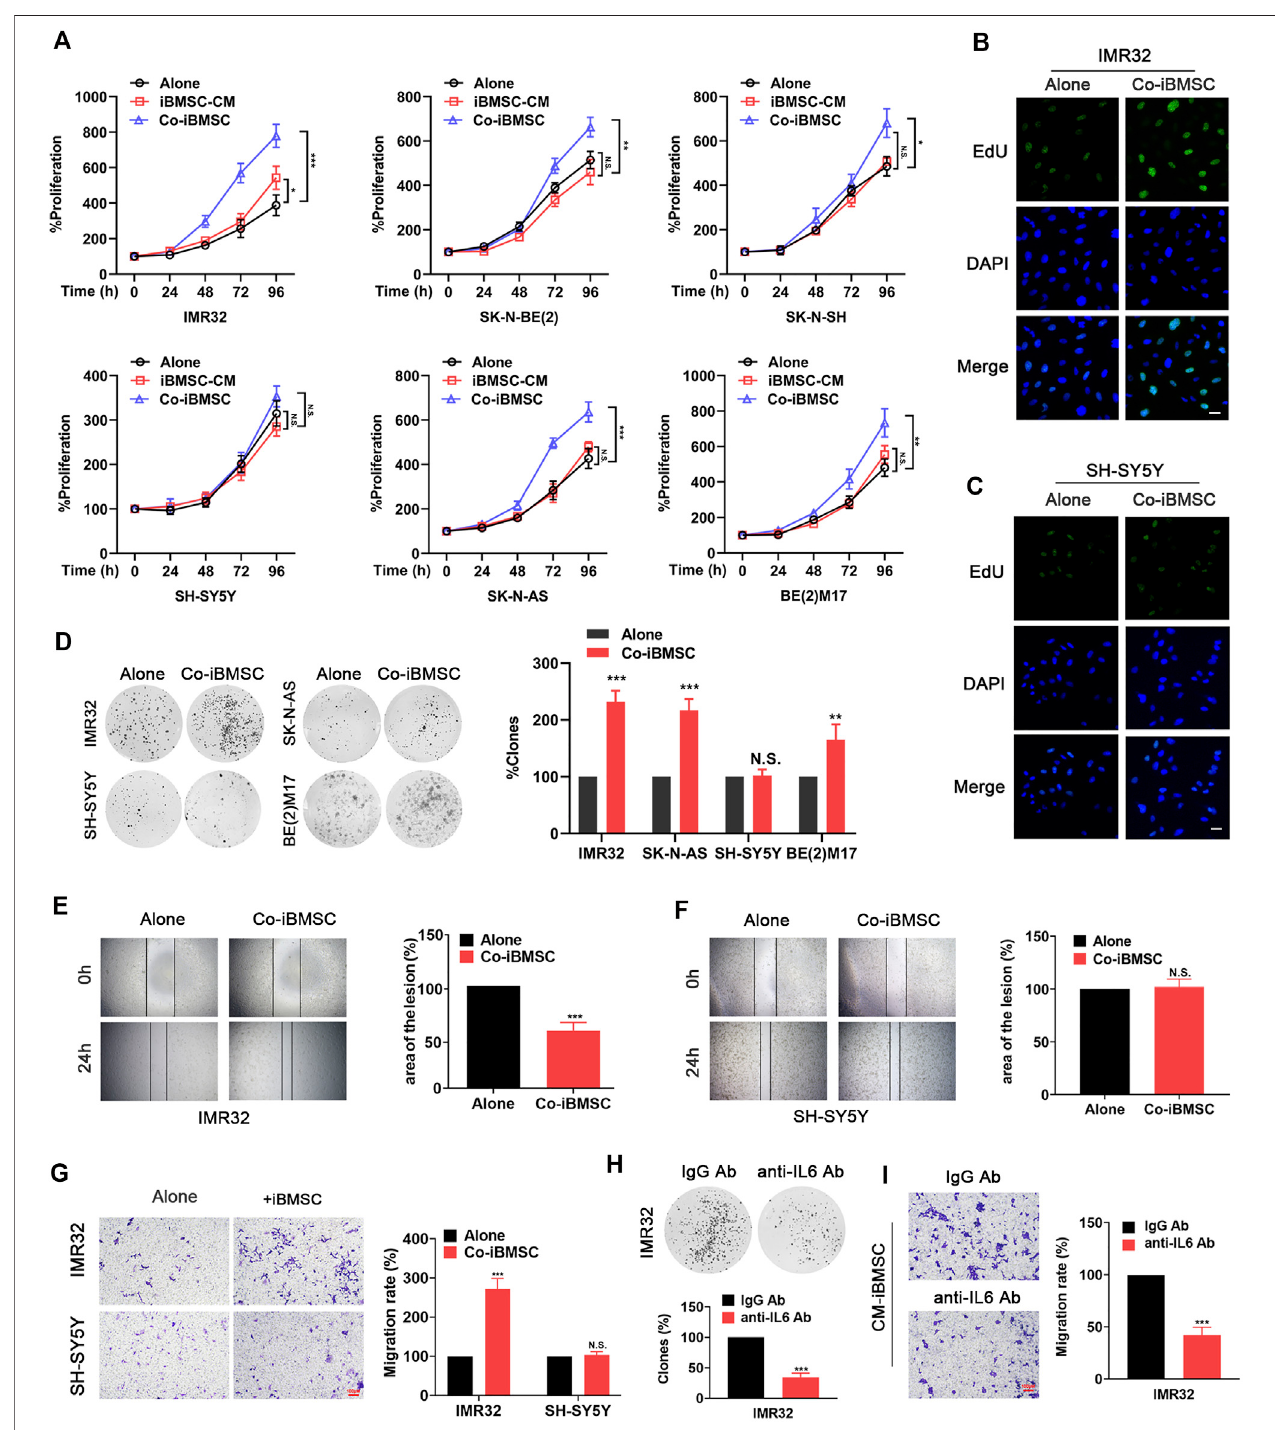
FIGURE3| IL6secretedbyiBMSCsisanimportantin fl ammatoryfactorthatfacilitiestheproliferationandmigrationofNBcells.TheNBcellswereculturedaloneor co-cultured withiBMSC or cultured withiBMSC derived CM. (A) TheviabilityofNBcellswasdetected byMTT assay.( *p < 0.05, **p < 0.01and ***p < 0.001vs. iBMSC- Alone) (B, C) The proliferation of IMR32 and SH-SY5Y cells was measured by EdU incorporation method. (D) Clone formation analysis was performed after 2 weeks of culture.( **p < 0.01and ***p < 0.001vsiBMSC-Alone) (E,F) Wound-healingassaywasperformedtore fl ectthemigrationabilityofIMR32andSHSY5Yinco-culture with and without iBMSC. ( ***p < 0.001 vs iBMSC-Alone) (G) Transwell migration assay of the IMR32 and SHSY5Y in co-culture with and without BMSC. Left: A crystal violet stain of migrating cells. Right: Rate of cells migrating through the membrane. Scale bar, 100 μ m. IMR32 was cultured with IL6 immune-deprived CM from